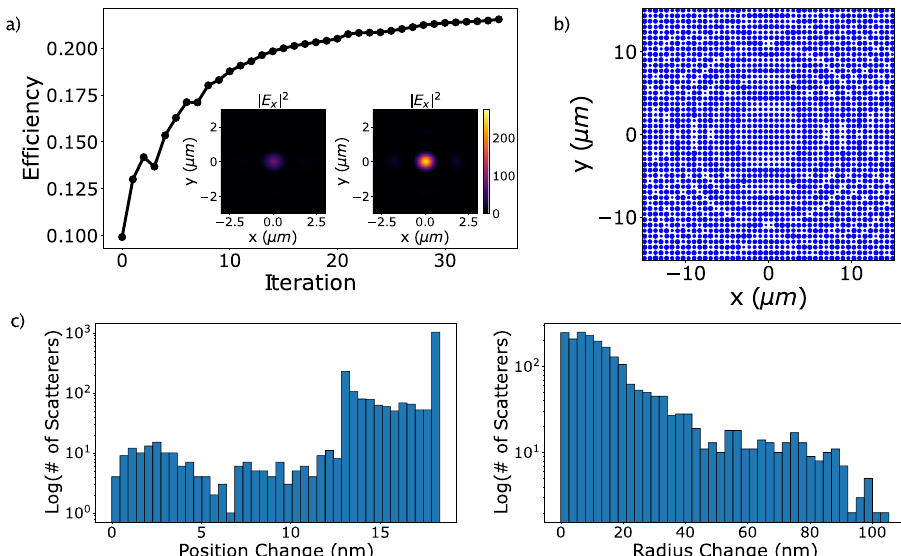
Fig. 4 Distributed Gradient-based optimization improvement of metalens design. a Lens ef fi ciency versus optimization iteration, where lens ef fi ciency is de fi ned as the ratio of the power within a circle of radius 3 × FWHM in the focal plane to the power incident on the metasurface. The initial metasurface is a 30 μ m × 30 μ m metalens with focal-length 20 μ m designed from the low aspect-ratio scatterer library used in Fig. 3b using the traditional periodic-approximation metasurface design approach. The metalens is designed and optimized for x-polarized light only. In 35 optimization iterations, the metalens ef fi ciency is almost doubled. The inset shows the intensity of the X-component of the electric fi eld in the focal plane before optimization (left) and after optimization (right). b Schematic of the cylindrical metasurface scatterers after optimization. c Histograms of the distance between the fi nal scatterer positions and the initial scatterer positions (left) and the absolute radius difference between the fi nal scatterer cylinders and the initial scatterer cylinders (right). As can be seen in these histograms, both the scatterer positions and radii change as a result of the